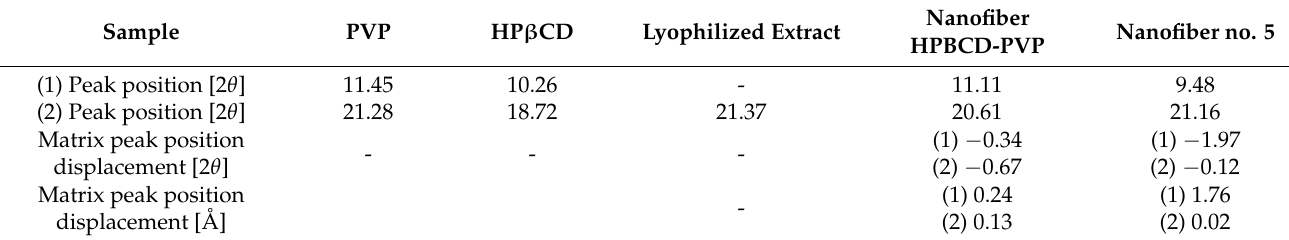
Table 5. XRPD Signals’